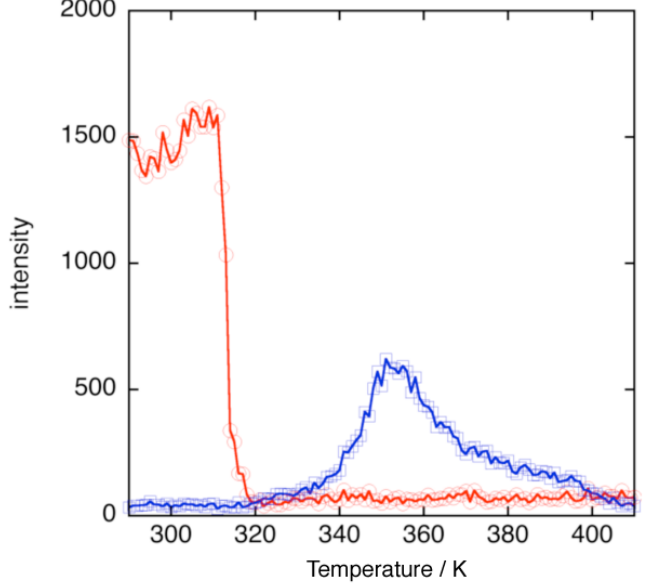
Figure 3. Temperature dependence of diffraction intensities at 2 θ = 8 ◦ (red) and 13 ◦ (blue). Based on the structural characterization, we conducted circular dichroism (CD) and diffuse reflectance spectroscopy in the solid-state to identify whether the bulk crystals are racemic or enantiomeric excess for 1 . Bulk crystals were carefully ground along the crystal facet, and CD spectra were measured. Figure S6 shows the diffuse reflectance spectrum and CD spectra. The spectrum showed absorption bands at 250 nm, 300 nm and shoulder at 400 nm. These bands are thought to be charge transfer (CT) bands. The CD spectra exhibit peaks at 250, 260 and 340 nm as shown in Figure S6 (Supplementary Materials), indicating that the bulk crystals of compound is enantiomeric excess rather than